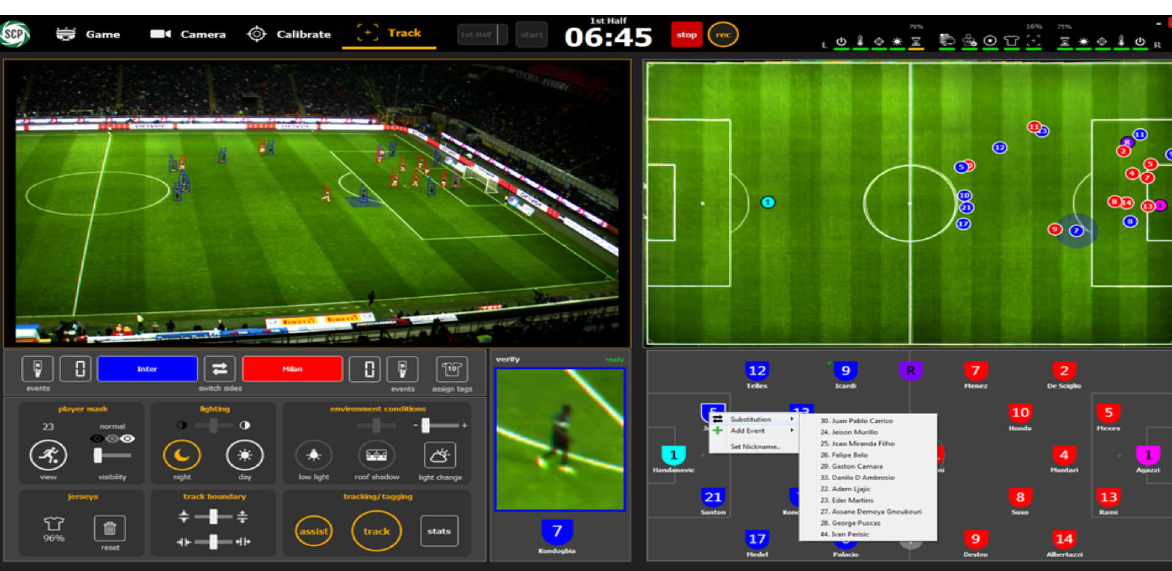
Figure 4. Sentio Sports optical tracking system computer software